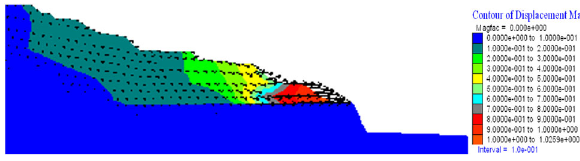
Fig. 17 Vector cloud diagram of slope displacement in section P-2